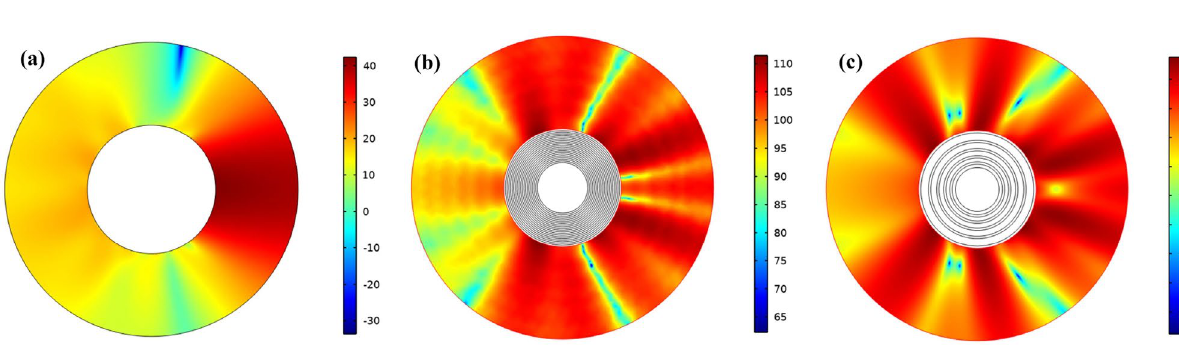
Figure 8. The scattering pressure level for ( a ) homogeneous cloak, ( b ) multi-layers cloaking with 20 layer and ( c ) composite lattice